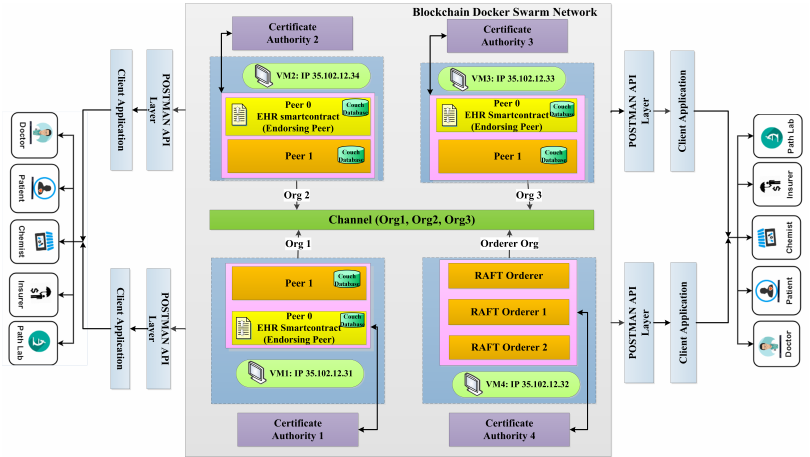
Figure 1. Multi-Host Framework for Blockchain-Enabled